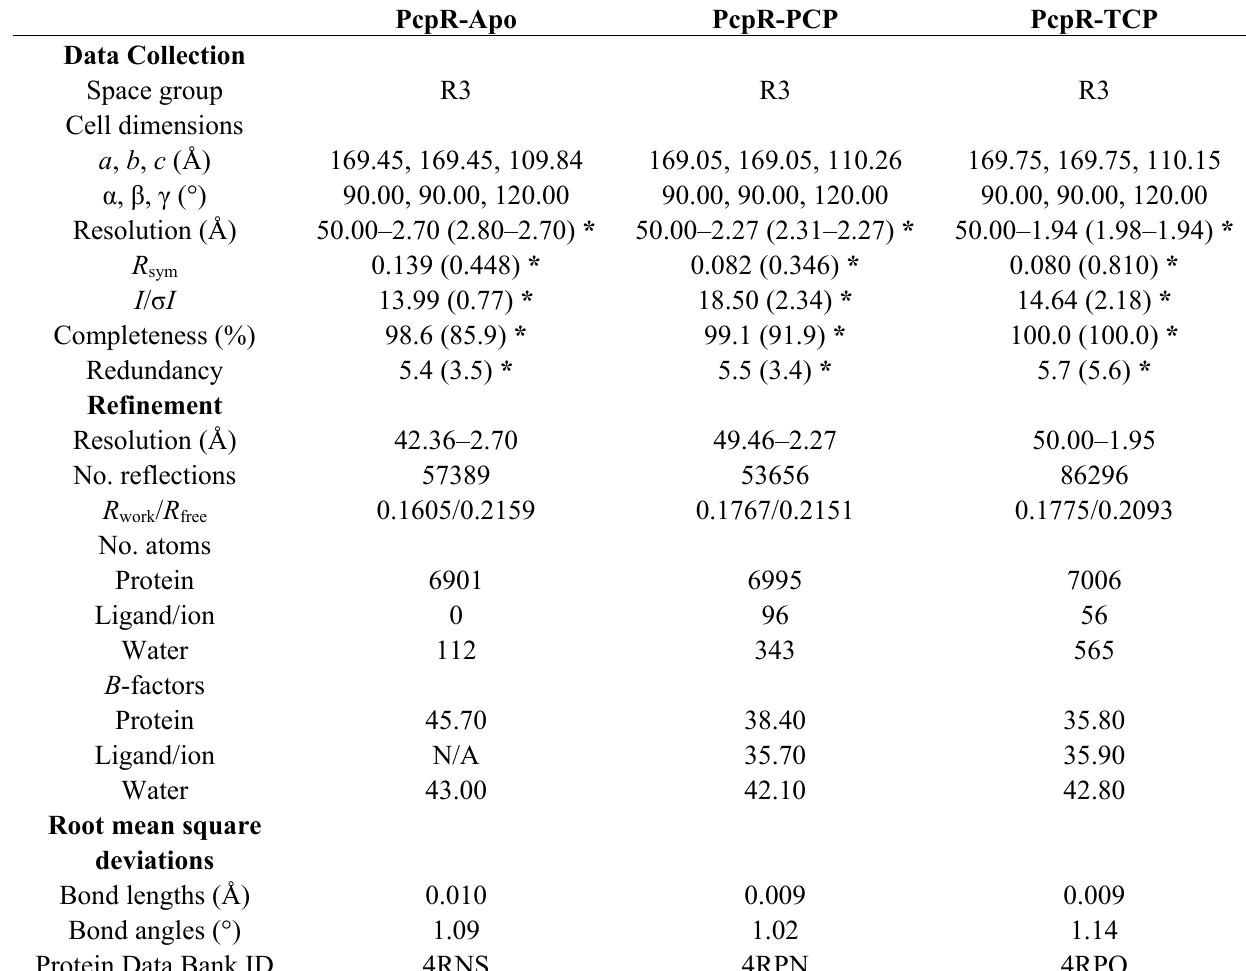
Table 1. Data collection and refinement